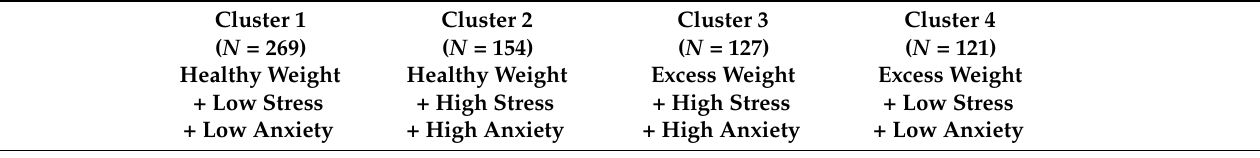
Table 2. Separate univariate ANOVAs on the outcome